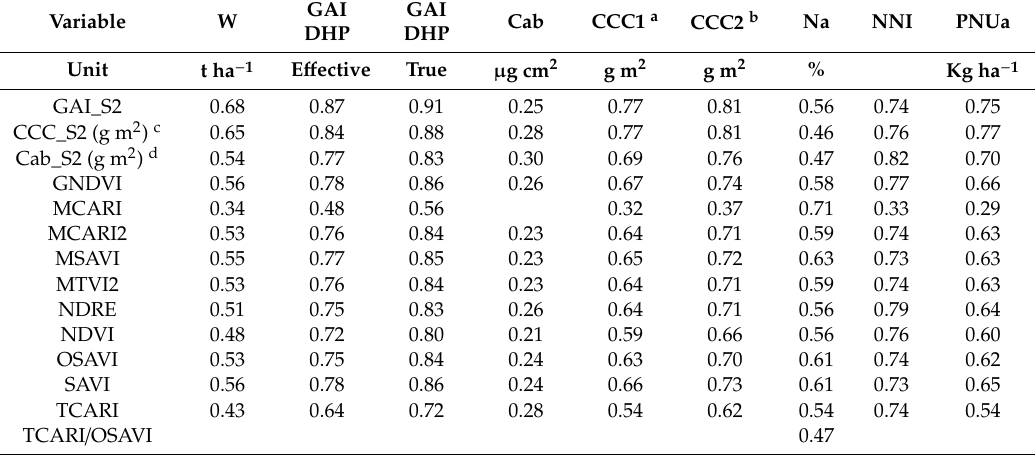
Table 7. Coefficients of determination for the linear regressions between field measured or calculated biophysical variables (BVs) and satellite (S2) derived Vis and S2_BVs for maize crop 2018. Only statistically significant values are